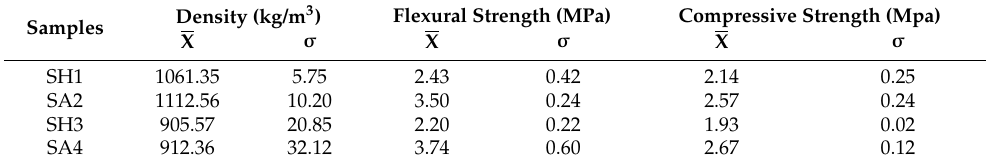
Table 4. Density and Mechanical Test results.